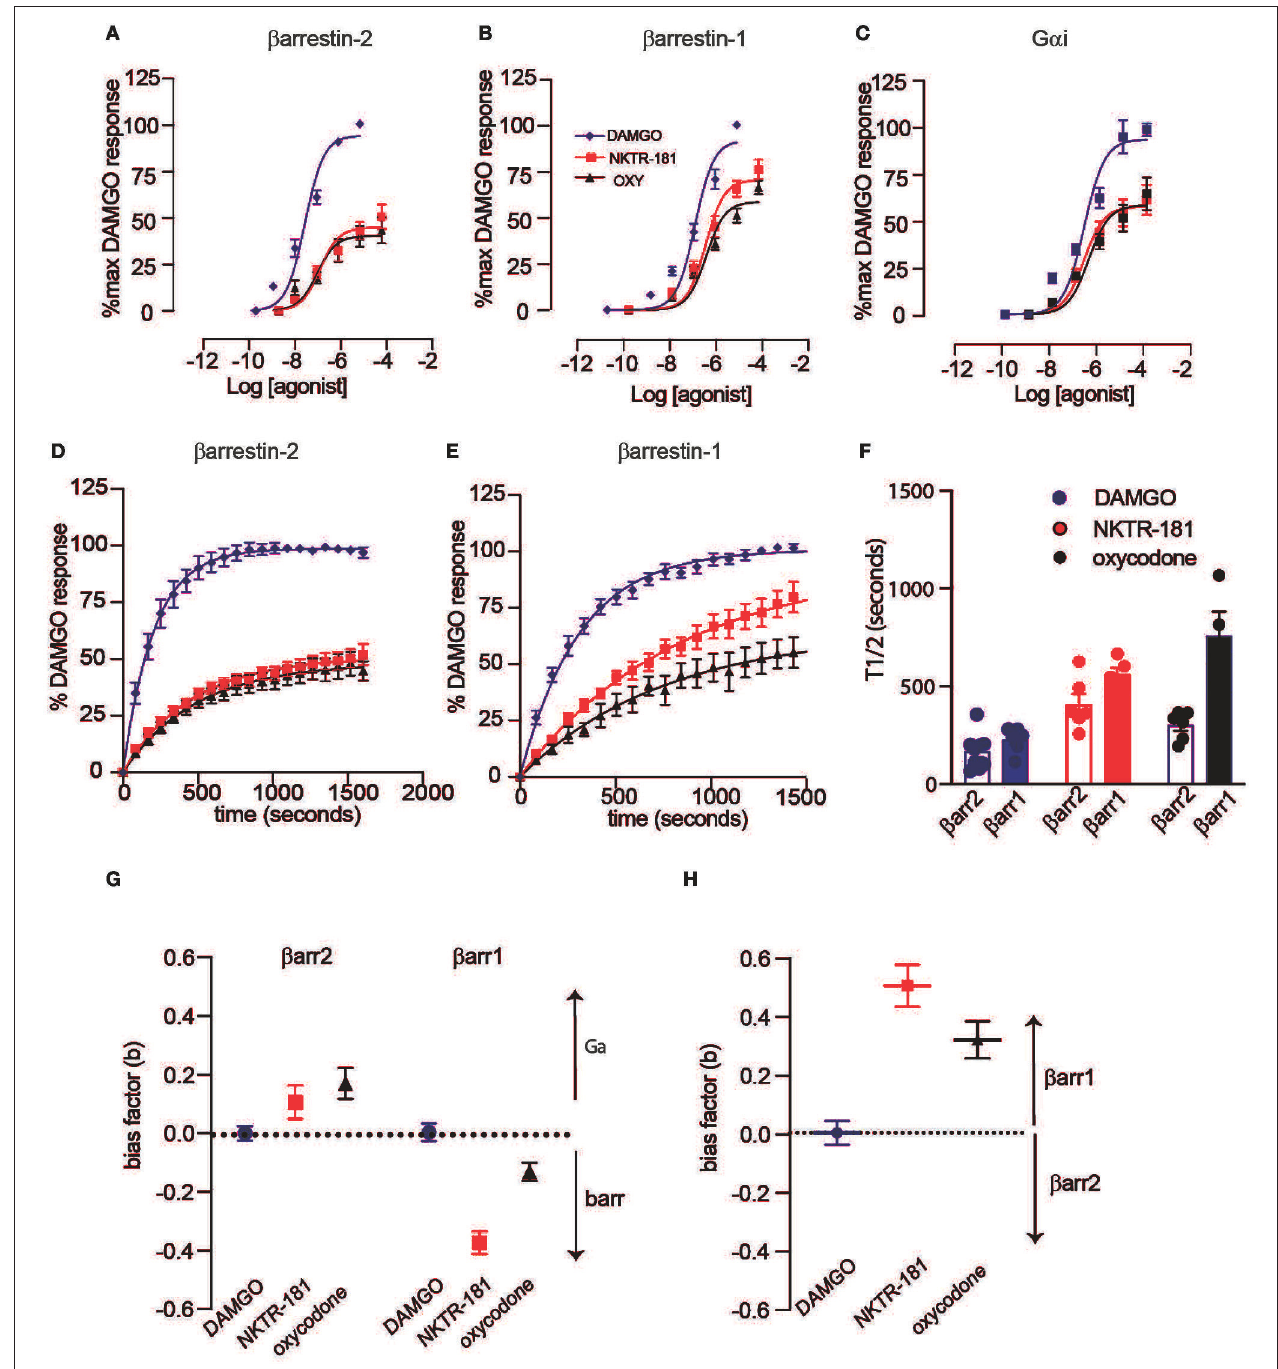
FIGURE 2 | NKTR-181-induced G-protein and β -arrestin recruitment to MOPr. HEK293 cells, transfected with MOPr-venus and either GNAi1-luciferase, luciferase- β arr2, or luciferase- β arr1, were treated with [D-Ala 2 , N-MePhe 4 , Gly-ol]-enkephalin (DAMGO) (0–10 β M), NKTR-181 (0–100 β M), or oxycodone (0–100 β M). (A–C) Dose-response curves showing agonist-activated NetBRET values [E 535 /E 490 minus the background signal observed with luciferase-tagged constructs alone and normalized to baseline bioluminescence resonance energy transfer (BRET) in untreated cells] as a percentage of the maximum DAMGO-induced response on the y -axis, and log agonist concentration on the x -axis for β arr2 (A) , β arr1 (B) , and G α i (C) . Data were fitted with a four-parameter, variable slope model with Hill Slopes constrained to one. (D–F) Time course of β arr2 (D) and β arr1 (E) recruitment at DAMGO (10 µ M), NKTR-181 (100 µ M), and oxy (100 µ M), fitted with a one-phase decay model, and recruitment rate comparison (F) . Bias factors were calculated for G α i vs. β -arrestin (G) or β arr1 vs. β arr2 (H) . Refer to Supplementary Table 1 , Tables 2 , 3 for statistics. Refer to Supplementary Figure 2 for the same analysis with morphine and fentanyl.